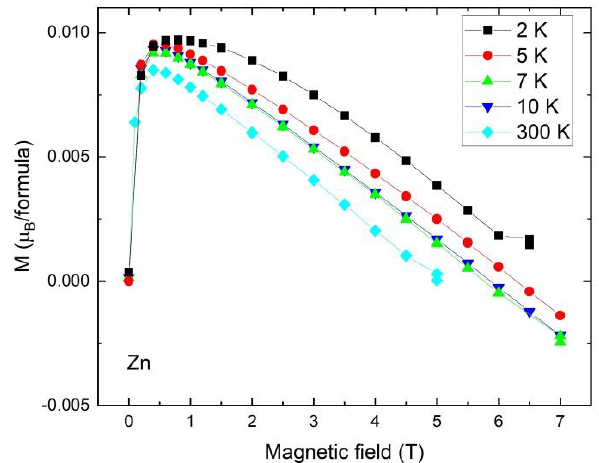
Figure 13. Magnetization of the Cd sample as the function of magnetic field at 2.0, 5.0, 7.0, 10.0, and 300.0 K. The data correspond to raw measurements after the extraction of an off-center linear diamagnetic background M / B ≈ − 0.05 µ B / formula T − 1 , associated with the sample holder.